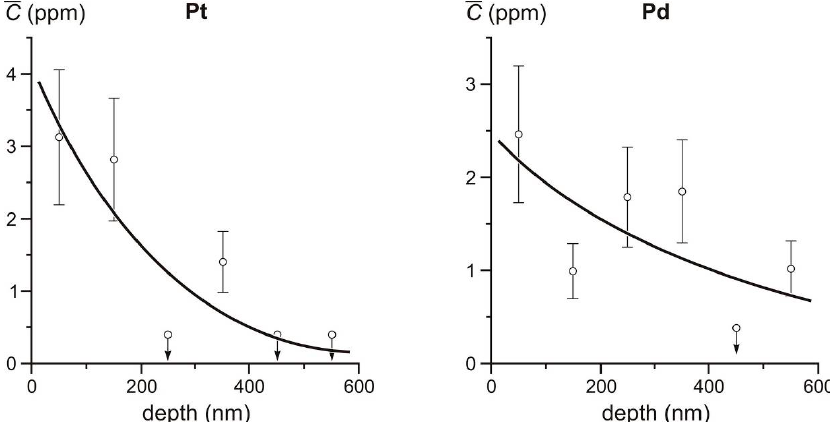
Figure 11. Distribution of the average content ( C ) of platinum and palladium in the surface layer of arsenopyrite crystal (sample M-129/10, Crystal 2) according to the results of LA-ICP-MS analysis (the Natalkinskoe deposit).